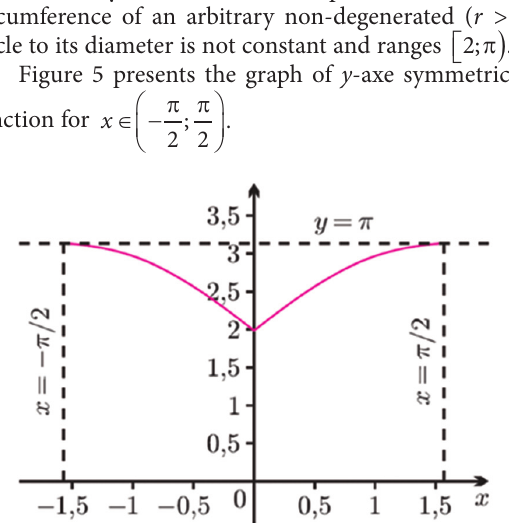
Fig. 5. The graph of function for the spherical circles (Kopacz